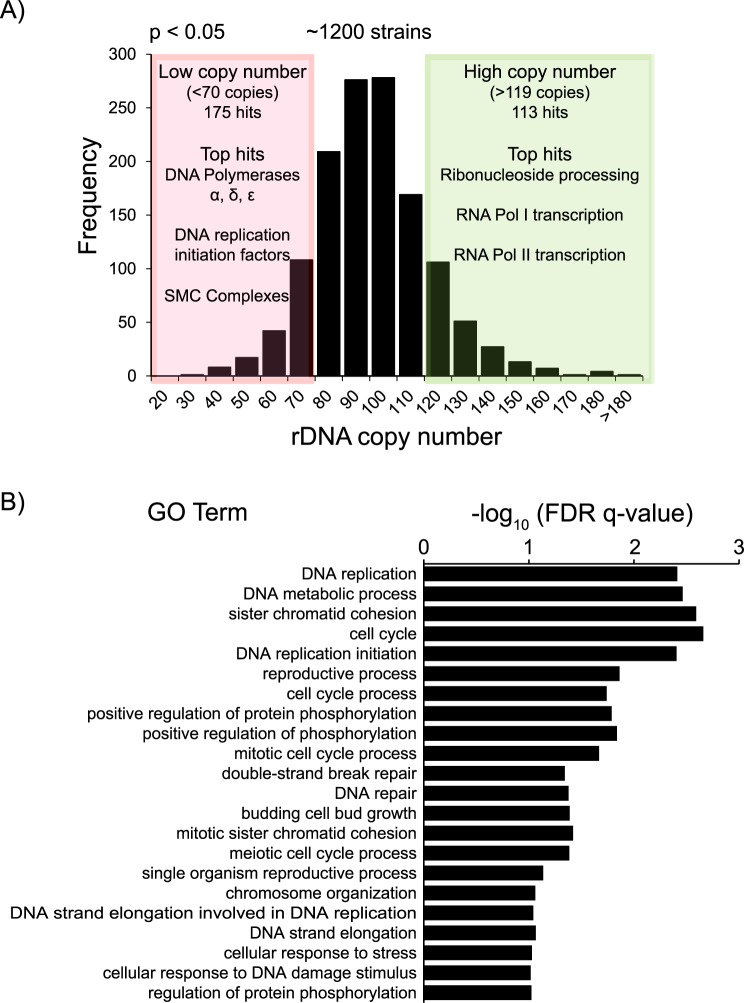
Screen for essential genes that maintain rDNA copy number.(A) Distribution of rDNA copy number across the yeast ts mutant collection. 175 and 113 strains had significantly lower (<70 copies) and higher copy number (>119 copies) respectively (p<0.05). (B) -log10 transformed FDR q-values for significantly enriched (p<0.001) GO terms (sorted in order of increasing p-values from top to bottom) in low copy number hits.